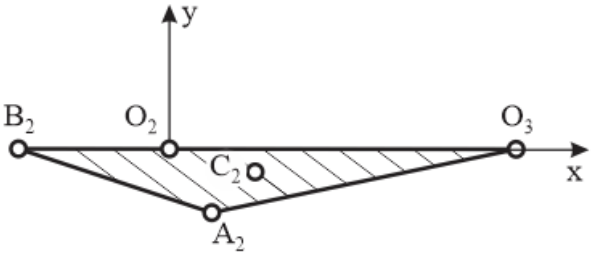
Figure 5. Schematic representation of the local coordinate system of arm no. 2.